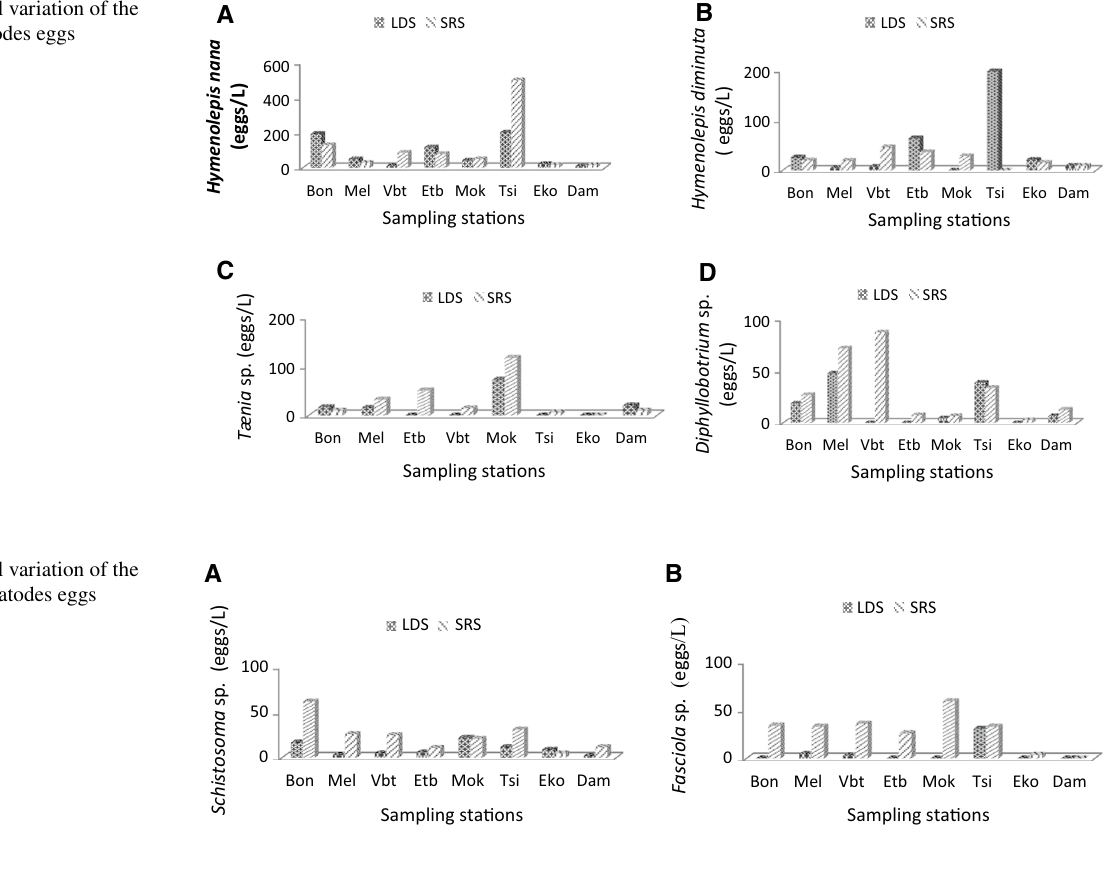
Fig. 6 Seasonal variation of the density of cestodes eggs